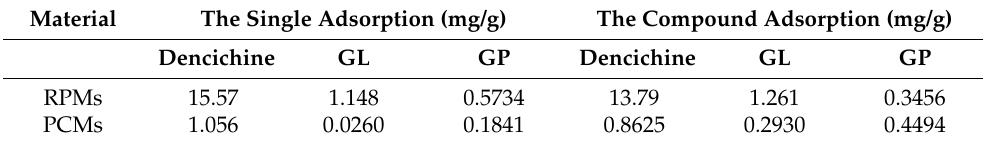
Table 3. Preferential adsorption of dencichine on RCMs and